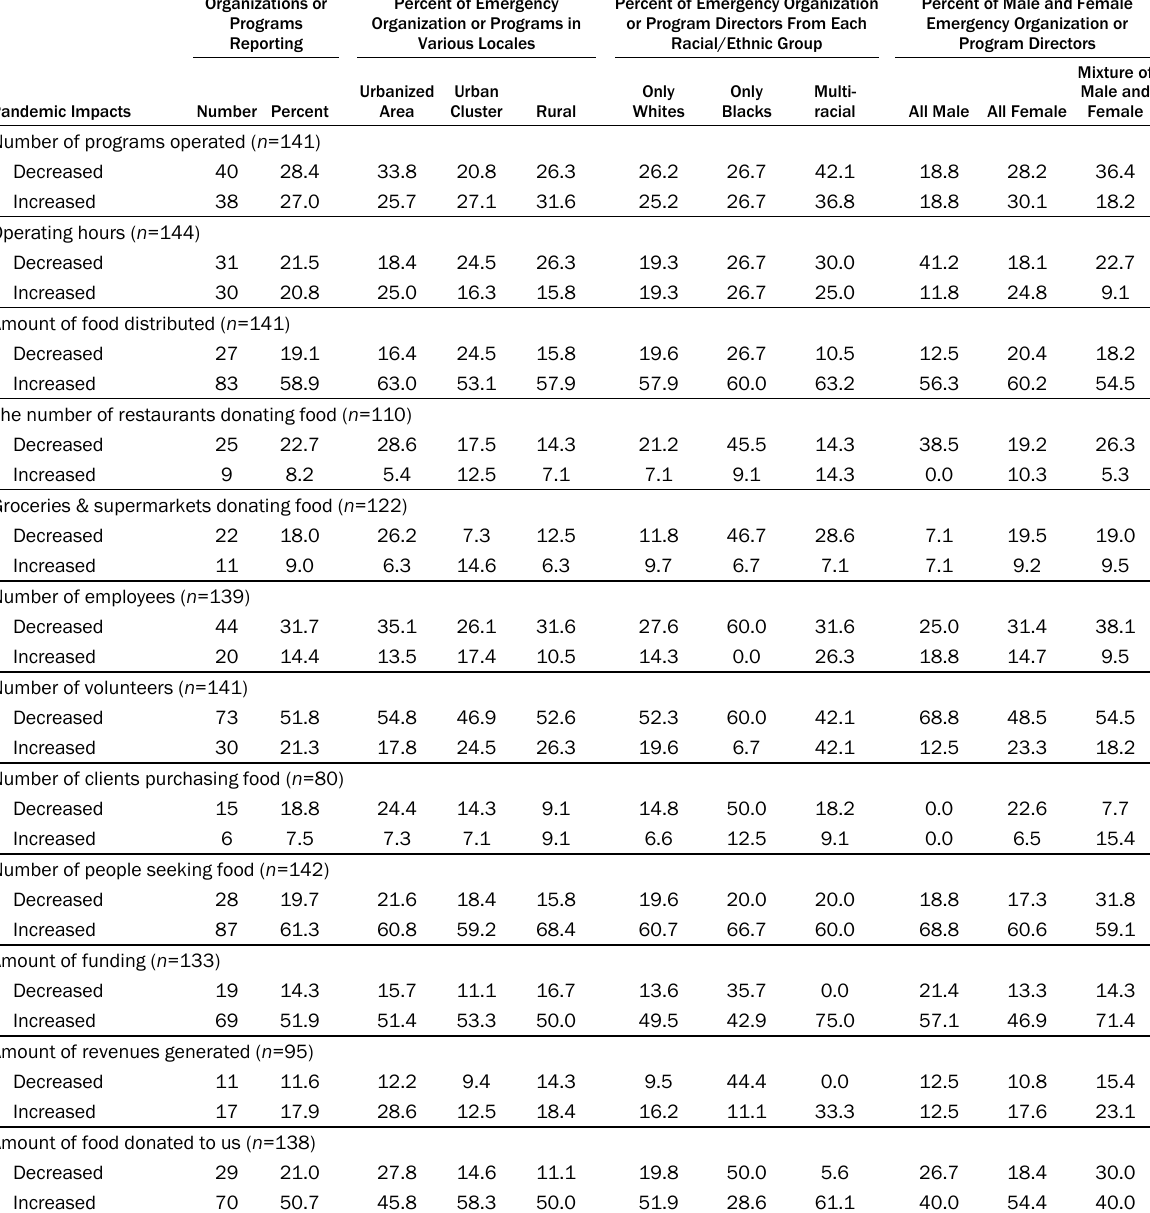
Table 7. Impacts of the Pandemic on Emergency Food Assistance